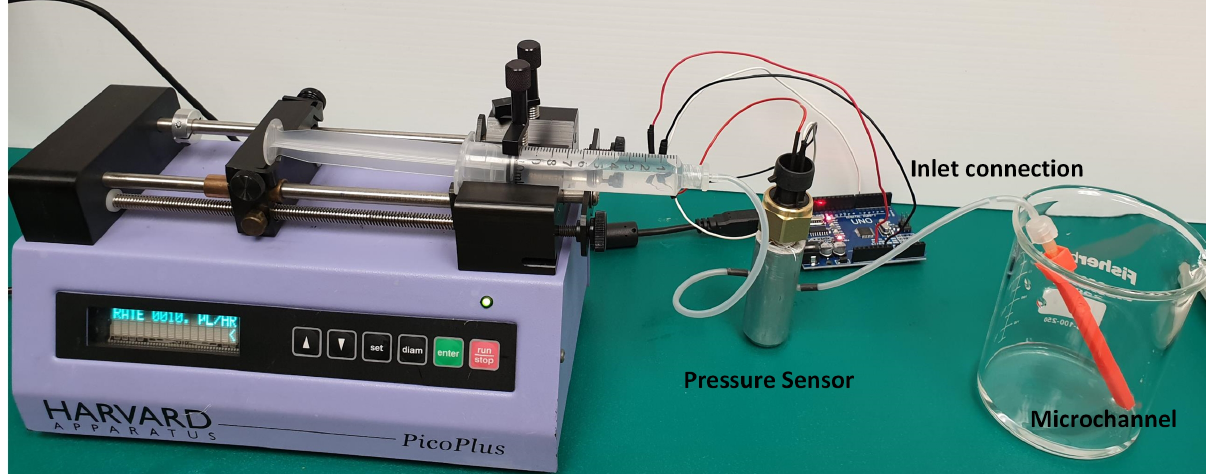
Figure 3. Pressure measurement experimental